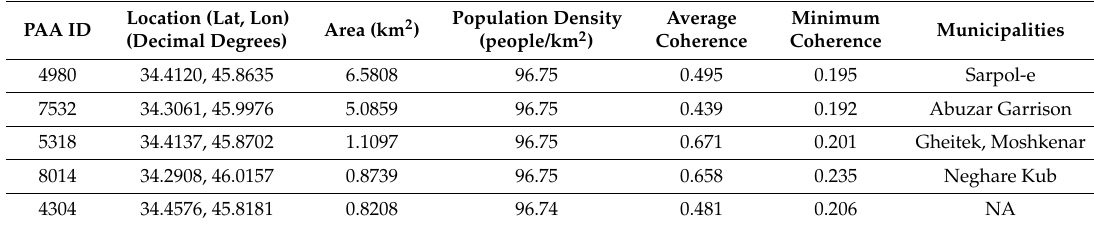
Table 2. Iran-Iraq Mw 7.3 PAA statistics for five most populous and largest detected PAAs (cf. Figure 2D).